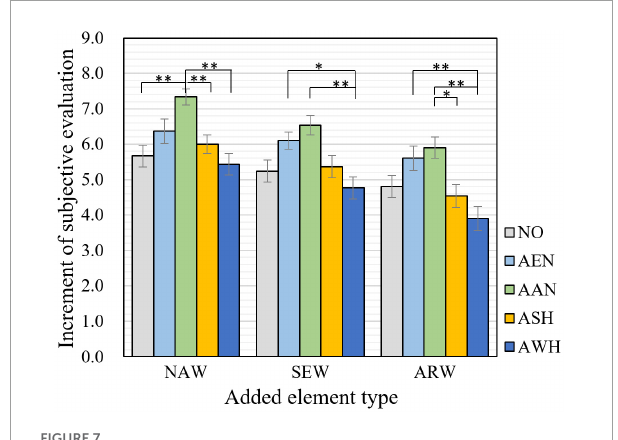
FIGURE7 Subjective evaluation of restoration after adding different audio elements in waterfront spaces. NAW, natural waterfront space; SEW, semi-natural-semi-artificial waterfront space; ARW, artificial waterfront space; AEN, auditory elements of environment-nature; AAN, auditory elements of animal-nature; ASH, auditory elements of on-shore human activity; AWH, auditory elements of on-water human activity; NO, no element added. (The error bars represent the standard errors on the averages: ± 1SE). Asterisks indicate statistically significant differences in mean scores (* p < 0.05; ** p <